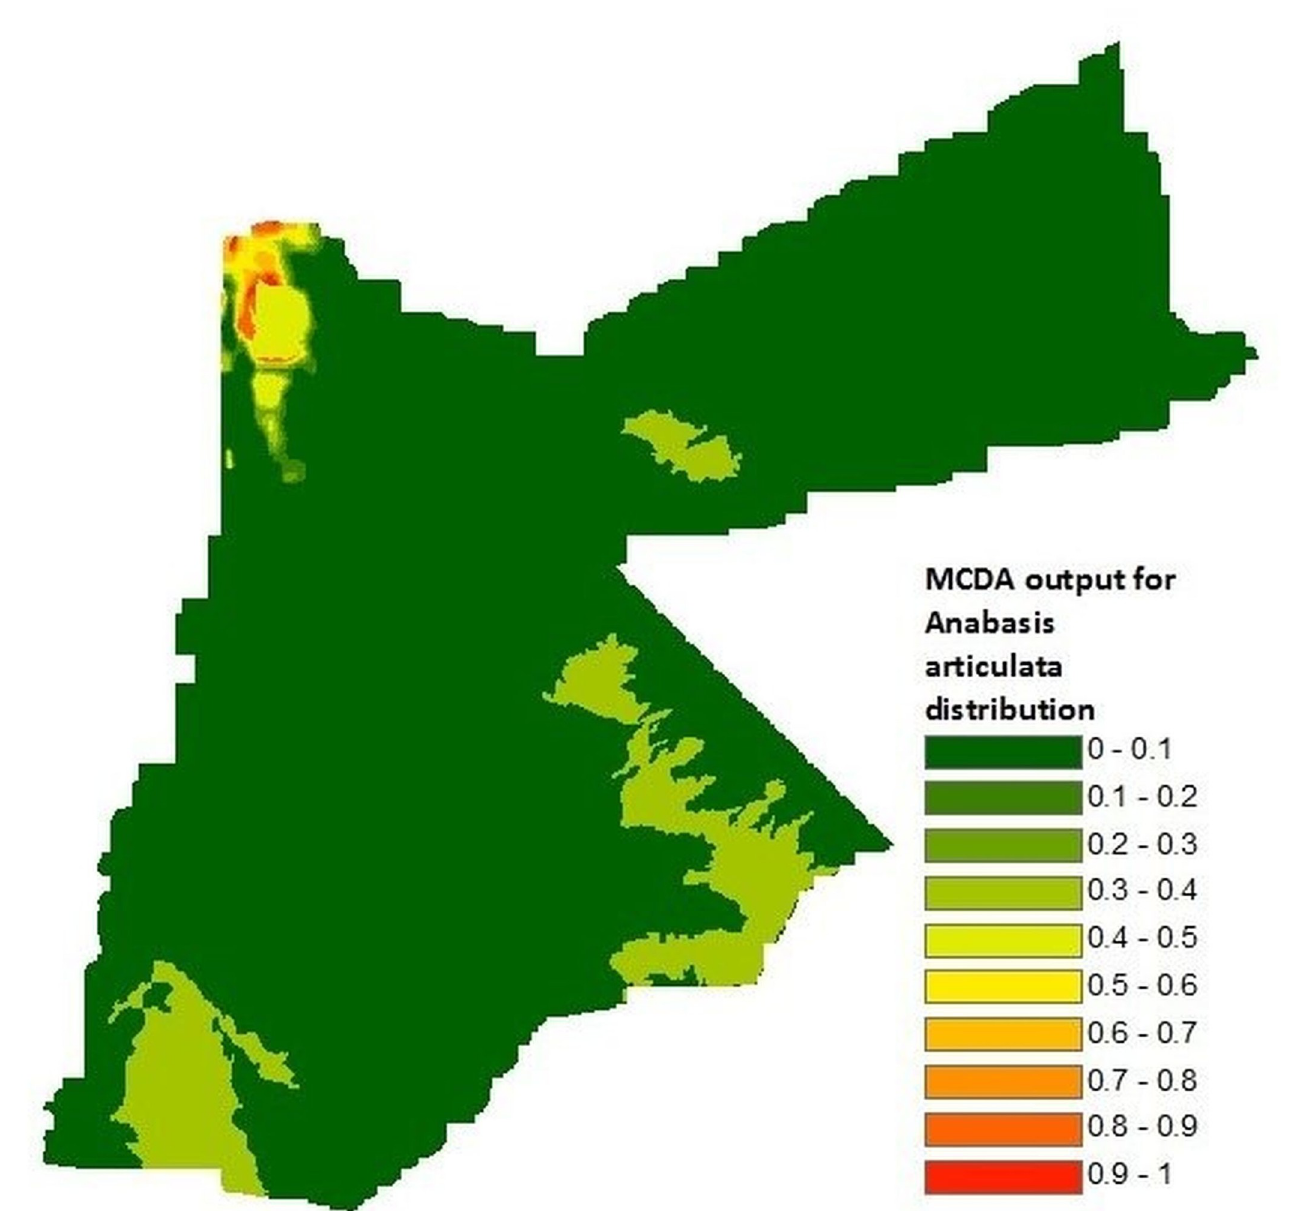
Fig 2. Multicriteria decision analysis output for the suitability distribution of Anabasis articulata . This was used as a proxy for the distribution of Psammomys obesus ; a predictor variable for the occurrence of Phlebotomus papatasi